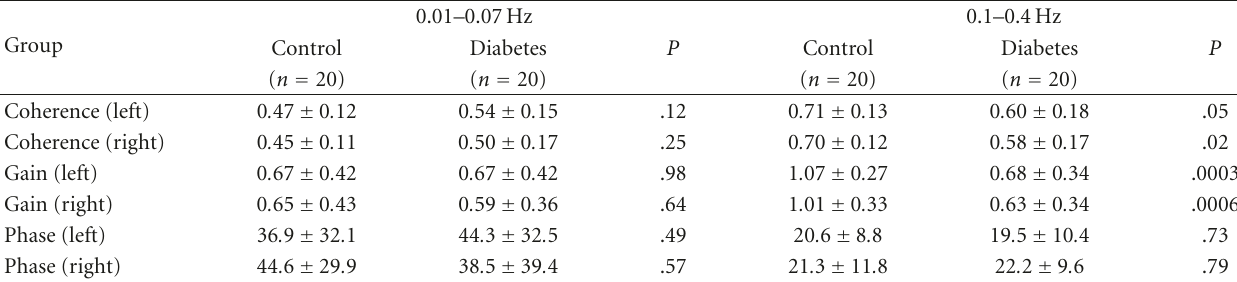
Table 1: Transfer function results. Adapted from [16]. P values indicate between group comparisons.